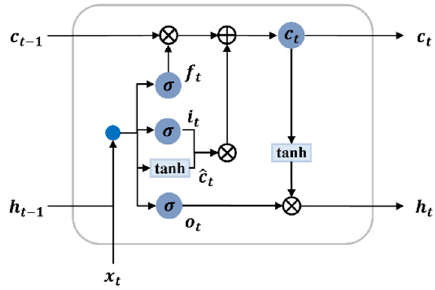
Figure 9. Overall architecture of LSTM